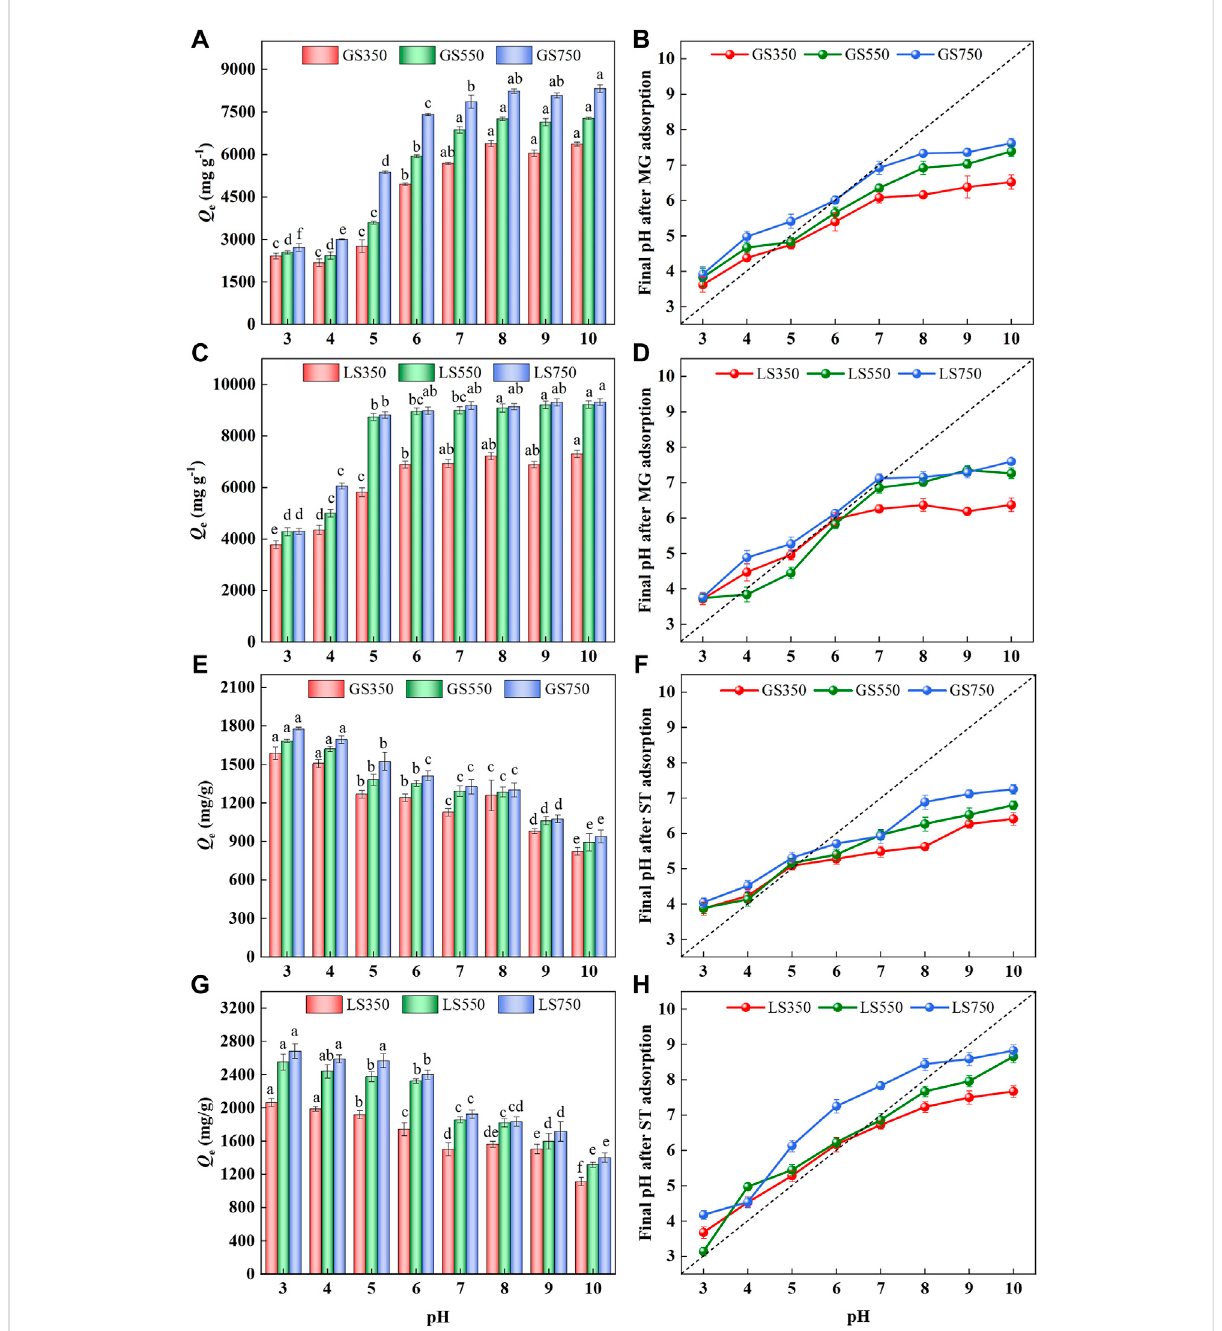
EffectofinitialpHonadsorptionofMG (A,C) andST(e.g.,)byGSBCandLSBC,and fi nalpHvalueafterdyeadsorption (B,D) ,(fandh).[Conditions] For MG or ST, initial concentration of 3,500 mg L − 1 , 15 mg biochar, initial pH of 3 – 10, 24 h. The error bars represent the standard deviation of the mean values. The different letters above the histogram indicate signi fi cant differences at p < 0.05 (ANOVA and Duncan ’ s multiple range test using SPSS